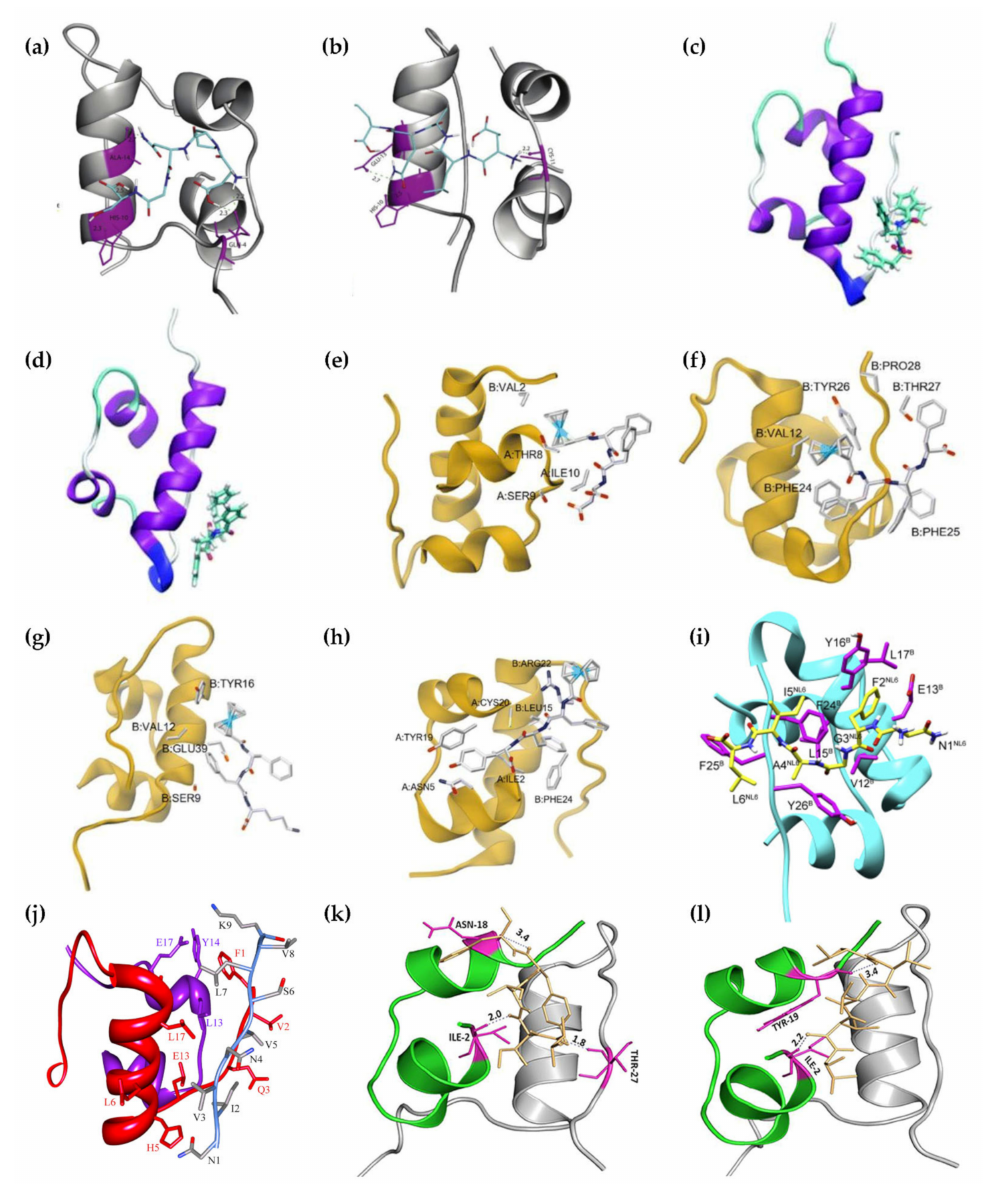
Figure 4. Molecular models of insulin interacting with different peptide inhibitors. ( a )